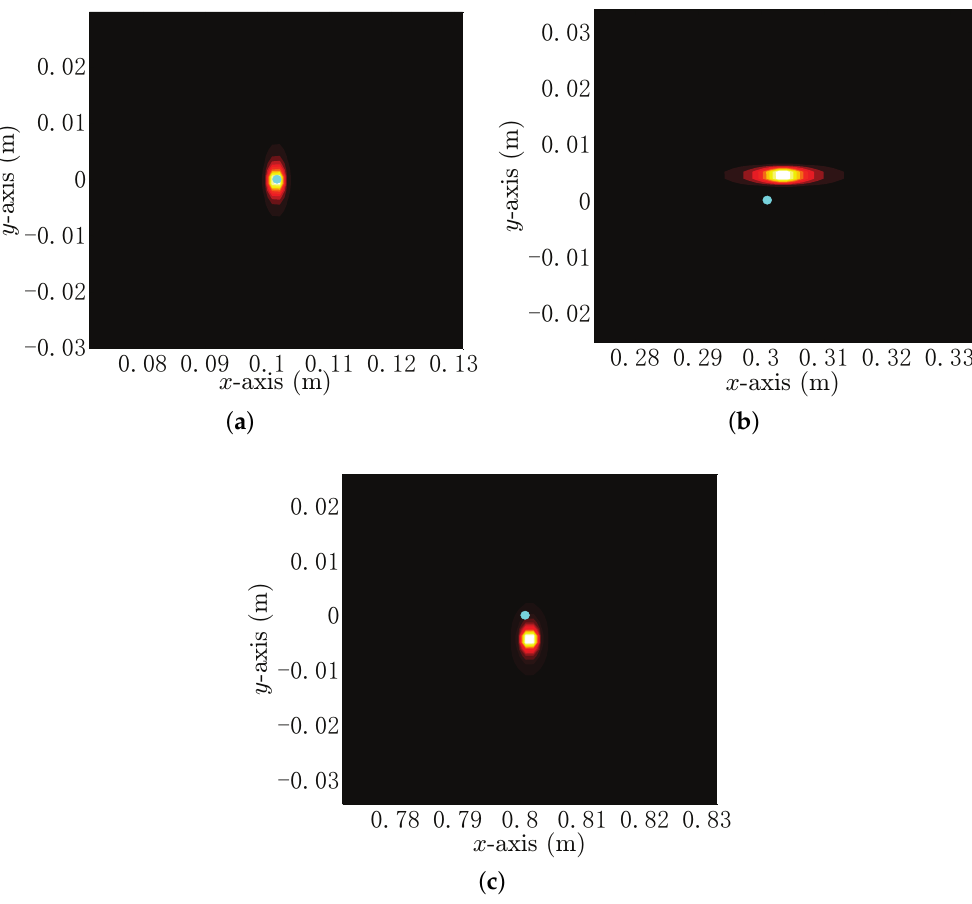
Figure 5. The spectrum images are given based on the MP-MUSIC for SNR = 20 dB. The real position of the insulator target is marked with a blue point, and the highlighted spots in each of the spectrum images indicates the estimated position of the target. ( a ) The spectrum image of the insulator target whose true localization is ( 0.1,0,0.1 ) m; ( b ) the spectrum image of the insulator target whose true localization is ( 0.3,0, 0.1 ) m; ( c ) the spectrum image of the insulator target whose true localization is ( 0.8,0,0.1 )